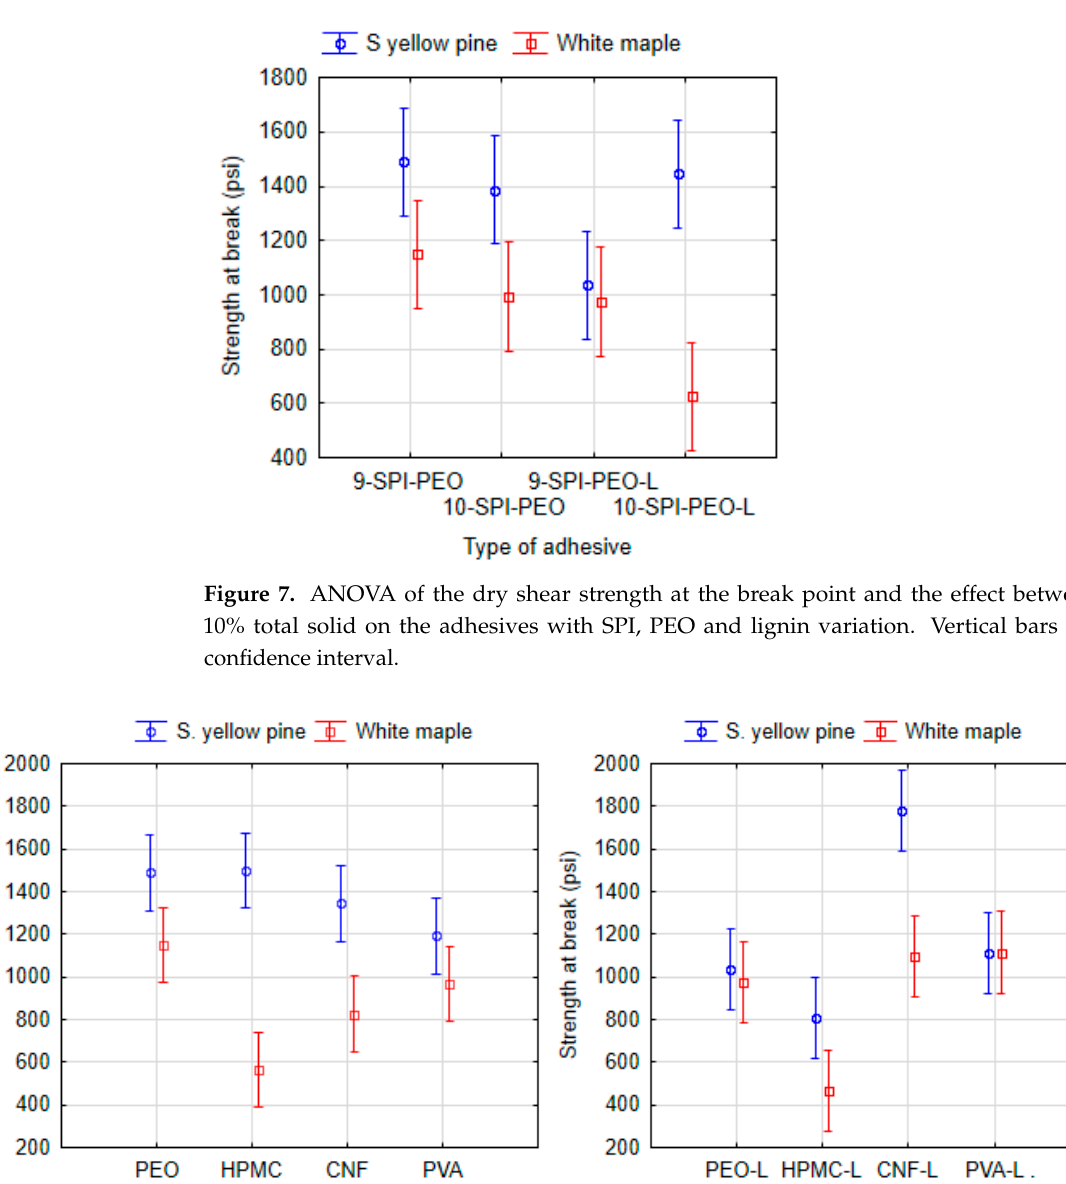
Figure 8. ANOVA of the dry shear strength at break point of proposed adhesives with SPI base and 9% total solid. The left picture shows the dependency of coadjutant type on the shear strength and the right picture shows this dependency with addition of kraft lignin. Vertical bars denote 95% confidence interval.